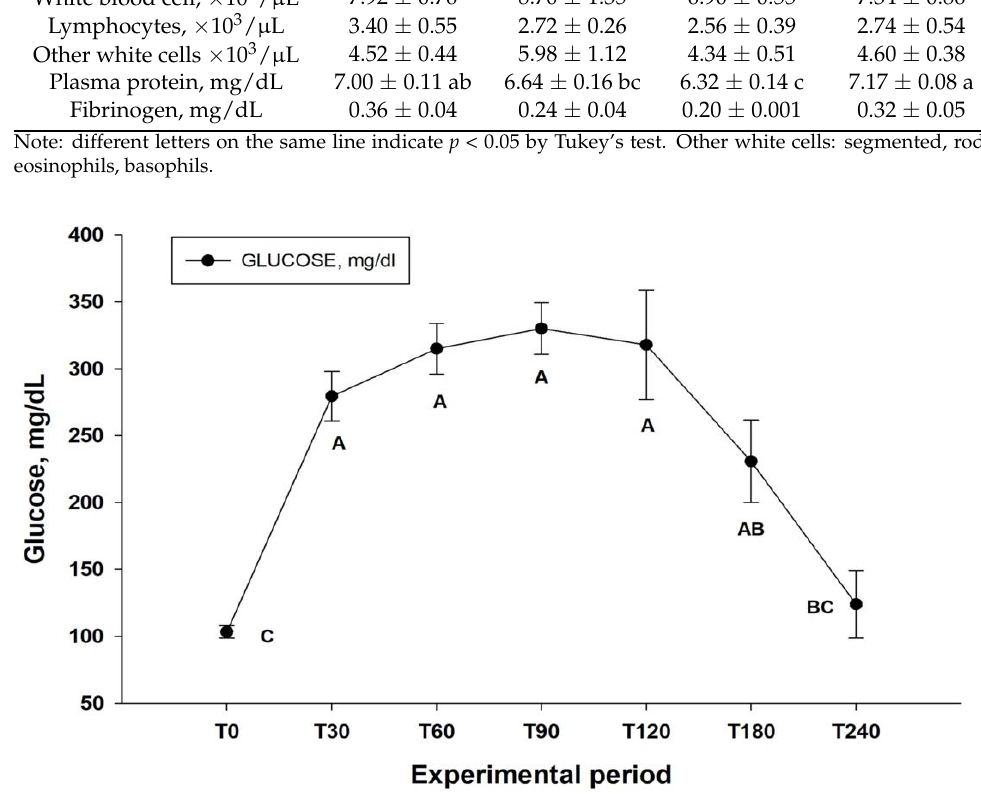
Figure 3. Plasma glucose concentration before and after the ingestion of ripe mangoes with peels for the characterization of the postprandial curve of the mangoes. Different letters indicate that p < 0.05 by Tukey’s test.